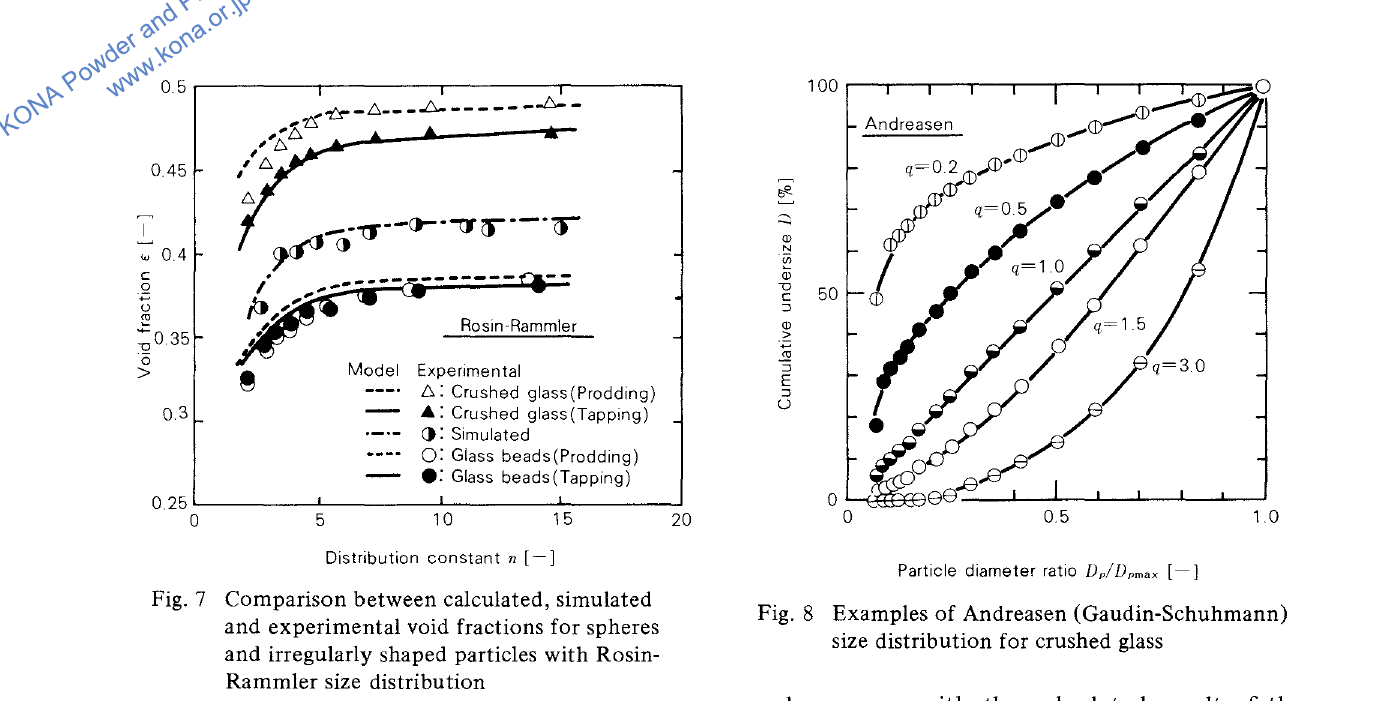
Fig. 8 Examples of Andreasen (Gaudin-Schuhmann) size distribution for crushed